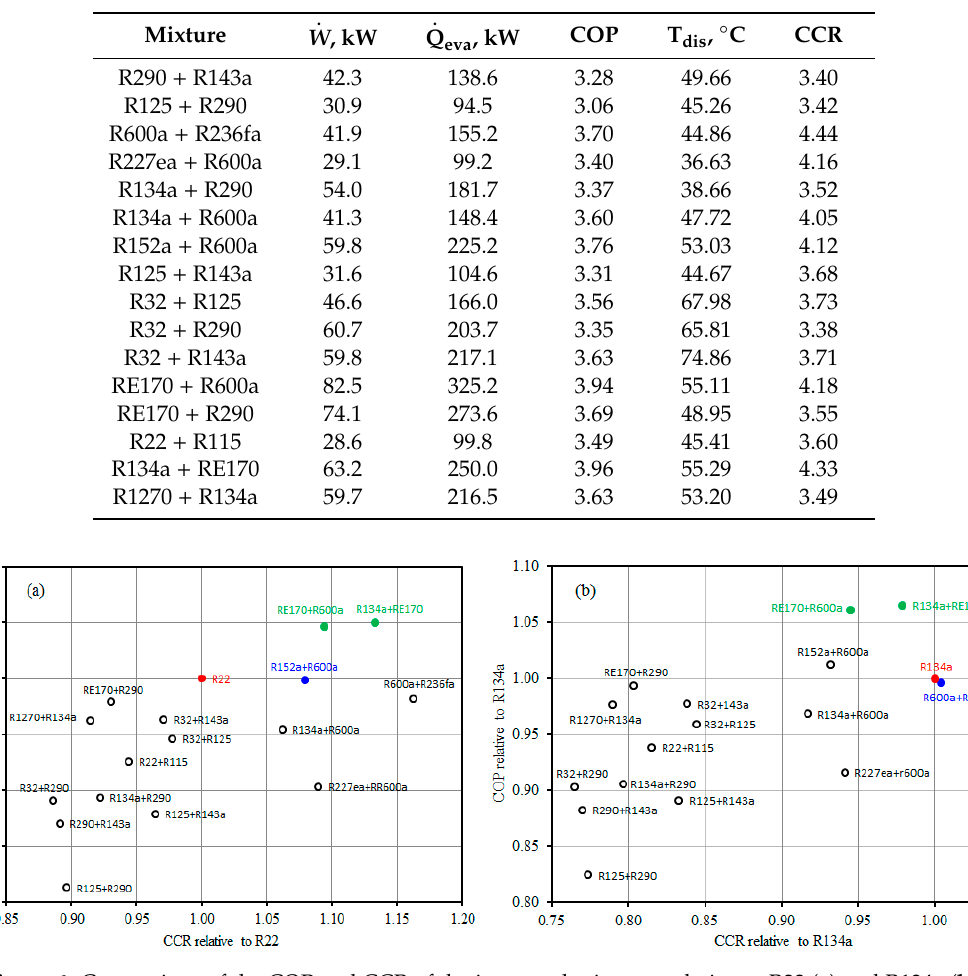
Figure 6. Comparison of the COP and CCR of the inspected mixtures relative to R22 ( a ) and R134a ( b ).